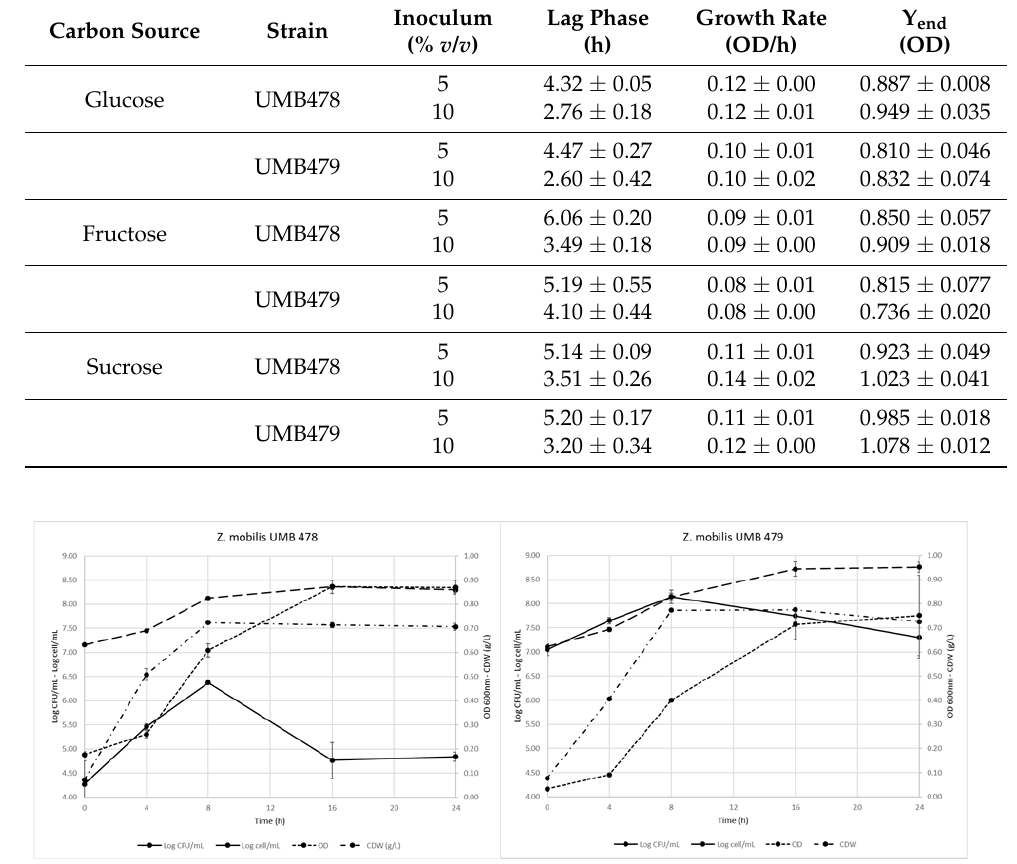
Table 1. Growth curves fitting parameters of liquid cultures of Z. mobilis UMB478 and UMB479 containing glucose, fructose and sucrose, respectively, inoculated at 5 and 10% ( v / v ): lag phase duration (h), growth rate (OD/h) and final OD reached (Y end ). Mean and standard deviation of four replicates.